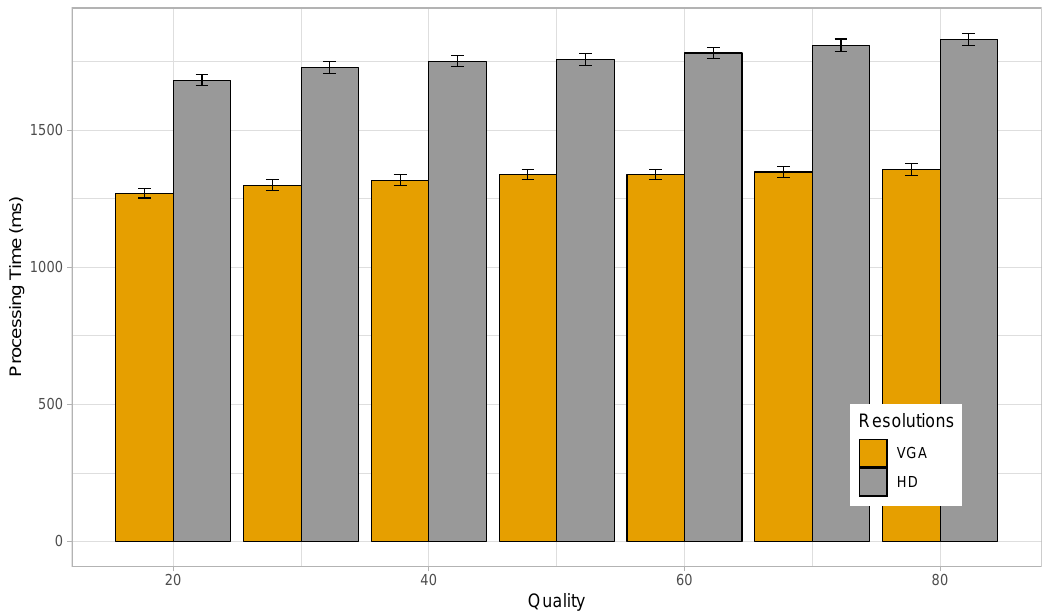
Figure 10. Time taken to processes images of varying quality by Nexus